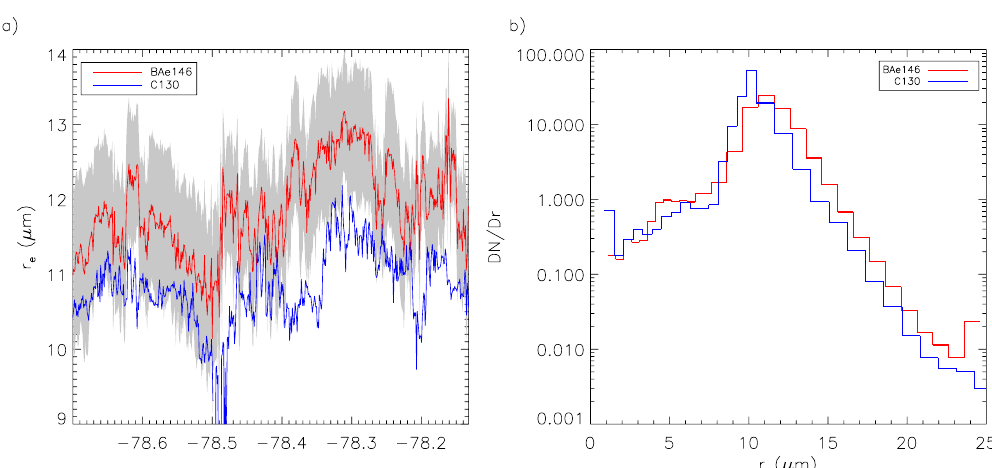
Fig. 6. CDP-measured effective radius (a) and averaged size distribution (b) during a comparison leg between the BAe-146 and C-130